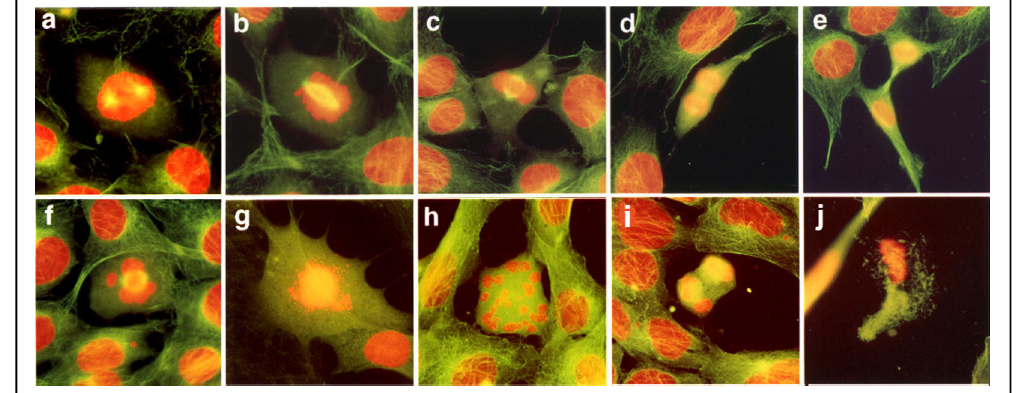
Figure 2. Deficient spindle MTs and cell division aberrations in As 3+ -treated cells. RFL6 cells on coverslips were incubated in 10% FBS medium without ( a–e ) or with ( f–j ) 10 µM As 3+ for 24 h. Cell division stages and aberrations were examined by visualization of the in situ chromosomes stained with propidium iodine (red) and spindle MT stained with FITC-conjugated anti-tubulin antibody (green). Note: Cytoplasmic FITC-labeled MTs are green; however, since spindle MTs overlap with DNA staining in red, they appear as yellow structures. a , prophase; b , prometaphase; c , metaphase; d , anaphase; e , telophase; f , chromosome lagging with a defective spindle at metaphase; g , chromosome scattering in the absence of spindle; h , chromosome clustering and scattering in the absence of spindle; i , chromosome lagging with a defective spindle at anaphase; j , apoptosis of a cell with aberrant division.